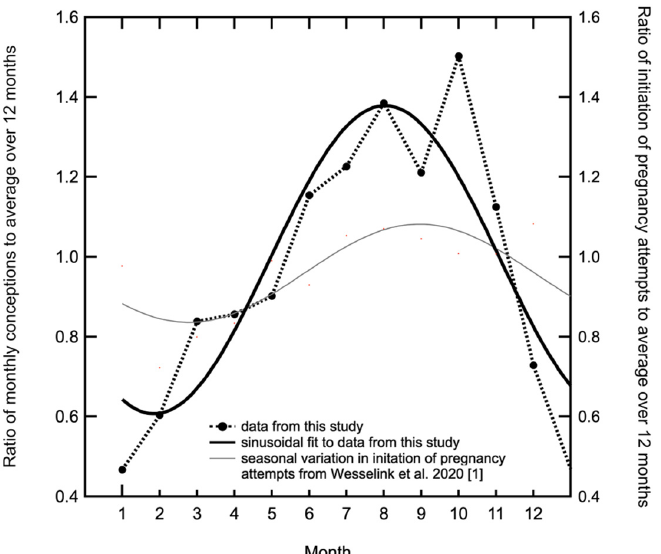
Figure 6. The monthly ratio to the annual mean of the conceptions resulting in live births in the present study. The heavy black curve is a sinusoidal least square fit to the data constrained to have a period of one year. The amplitude is 38.6% ± 5.9% of the mean monthly conceptions. Seasonal patterns in pregnancy initiation attempts from two cohorts PRESTO (5827 women) from Canada and North America and Snart Gravid (8504 women) from Denmark [1] (data from a total of 14,331 women), were combined to form the weighted average and fitted with a sinusoid constrained to have a period of one year, which is shown by the thin black curve, which has an amplitude of 12.3% ±